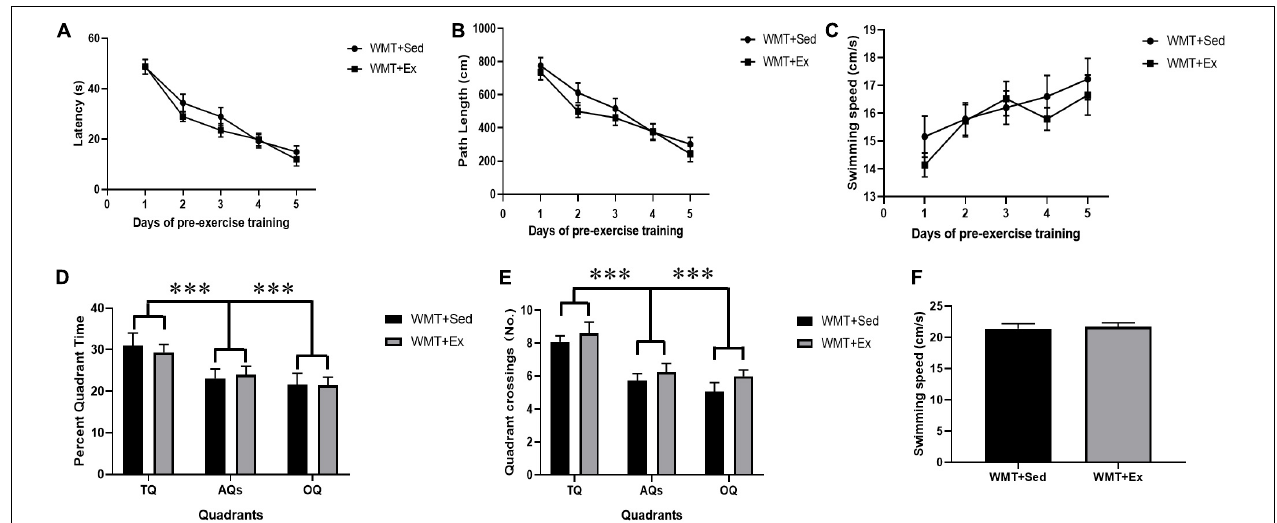
FIGURE 2 | Mice successfully acquired the spatial memory during pre-exercise learning. (A,B) Two-way repeated-measures ANOVA shows no difference between groups of mice that were sedentary with memory traces (WMT + Sed) and those with memory traces plus exercise (WMT + Ex) in their performance during pre-exercise training. (C) Comparison of swimming speed between the WMT + Sed and WMT + Ex groups during pre-exercise training. There is no difference in the swimming speed between groups. (D,E) Two-way ANOVA shows no difference between groups of mice in their performance during pre-exercise probe test, and mice shows significant larger time and more entries in the target quadrant (TQ) than that in the adjacent quadrants (AQs) and opposite quadrant (OQ). (F) Comparison of swimming speed between the WMT + Sed and WMT + Ex groups during probe test. There is no difference in the swimming speed between groups. Data are graphed as means ± SEM ( n = 13) and analysis used two-way repeated ANOVA (A–C) and two-way ANOVA (D,E) . ∗∗∗ p < 0.001.